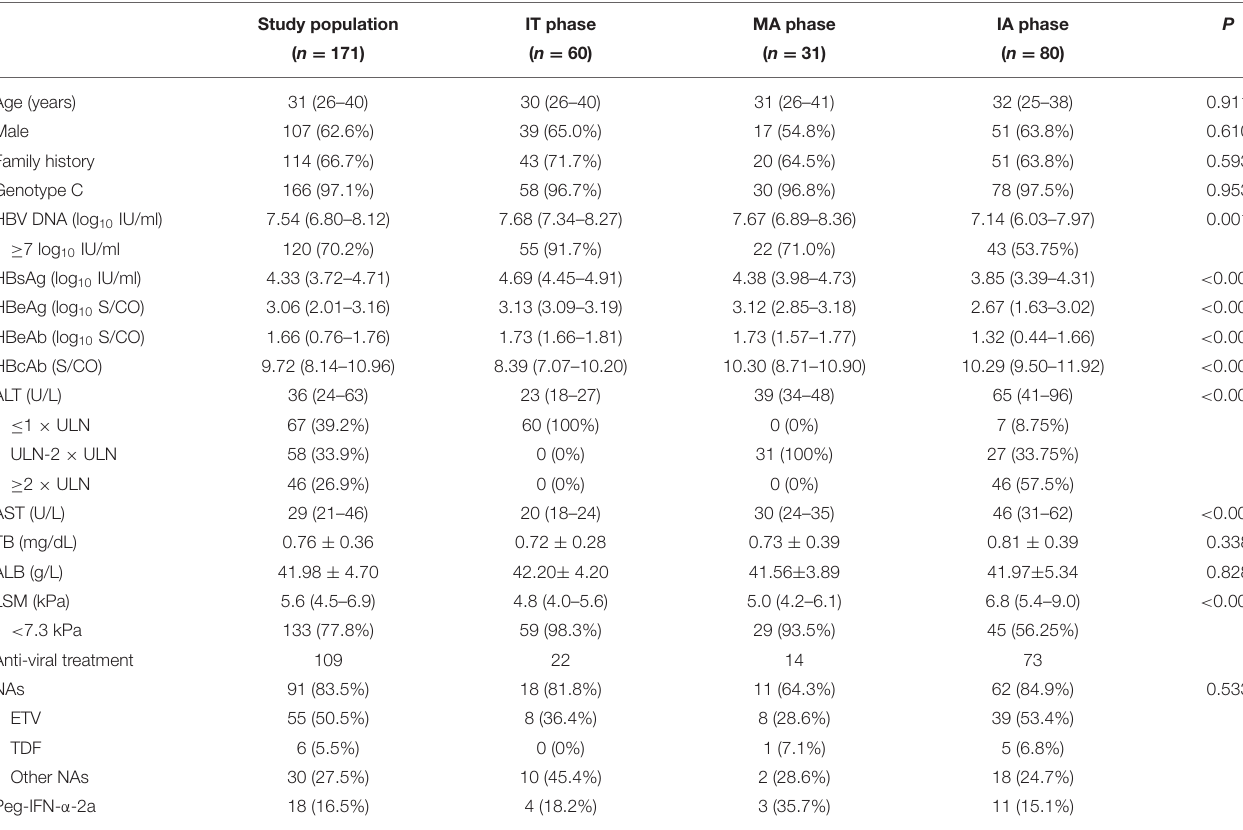
TABLE 1 | Baseline characteristics in liver biopsy-proven IT-, MA-, and IA-phase patients. Study population IT phase MA phase IA